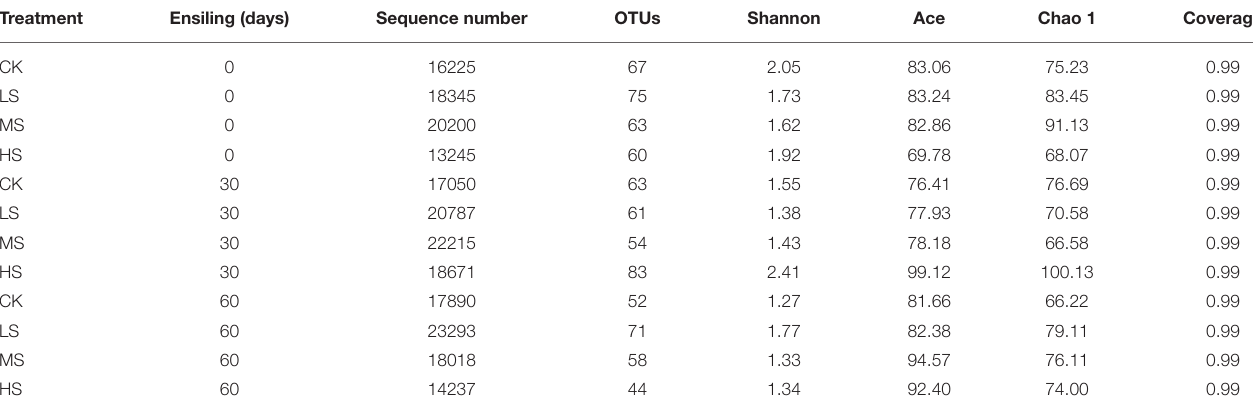
TABLE 5 | Alpha diversity of the bacterial community in fresh materials and alfalfa silage. Treatment Ensiling (days) Sequence number OTUs Shannon Ace Chao 1 Coverage